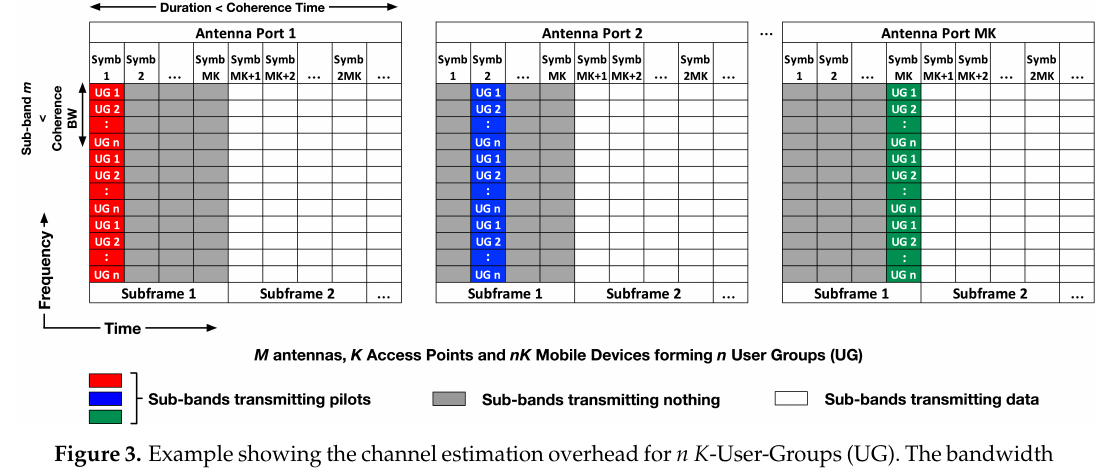
Figure 3. Example showing the channel estimation overhead for n K -User-Groups (UG). The bandwidth allocated for estimation is divided among the n K -User-Groups. Each group transmits pilot signals in its allocated